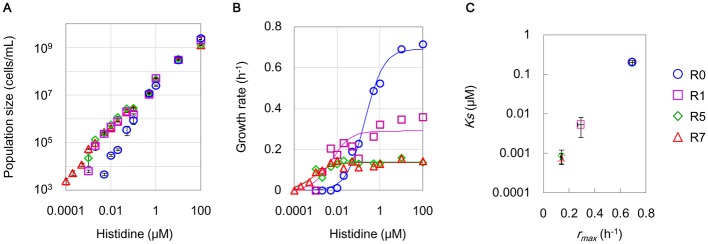
Growth rate and population size in response to various amounts of histidine.
A. Saturated population densities detected by FCM. The maximal cell concentrations experimentally acquired in the various concentration of histidine are shown. Blue circles, purple squares, green rhombuses and red triangles represent R0, R1, R5 and R7, respectively. Standard errors of triplicates are indicated. B. Experimentally evaluated exponential growth rates. The growth rates of the growing cells were calculated according to the average cell concentrations of any three out of 12–15 test tubes at the defined time scales. The data fit to the Monod equation are shown as solid lines. Open marks represent the experimental measurements. The concentrations of histidine varied from 0.1 nM to 100 μM. C. Theoretically estimated Ks and r
max. The parameters Ks (right) and r
max (left) were calculated according to the Monod equation using the experimentally acquired growth rates shown in B. The standard errors derived from the theoretical fitting are indicated.